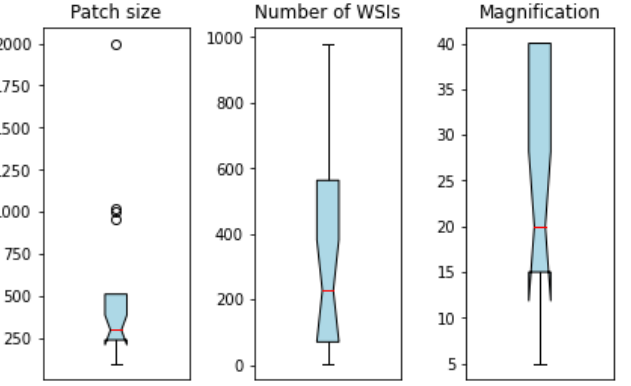
Figure 2. Minimum, median, and maximum amount of patch size, number of WSIs, and magnification. The median amount of each parameter is represented by a red vertical